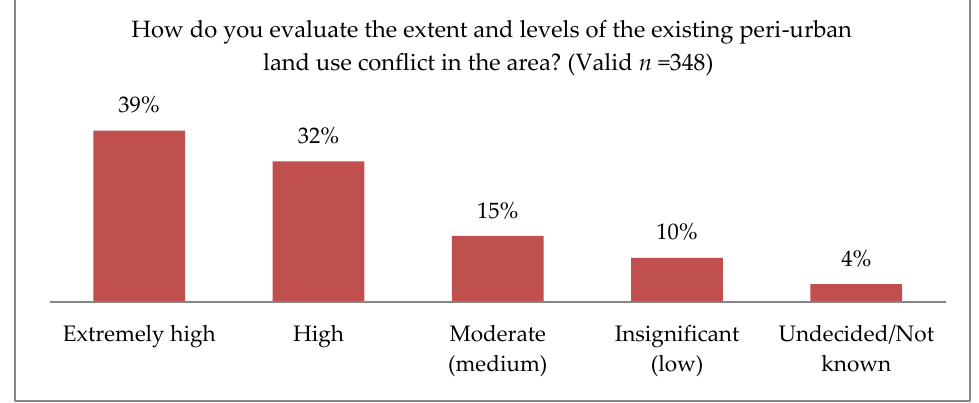
Figure 8. Households perception on the extent and levels of the existing peri-urban land use conflict.